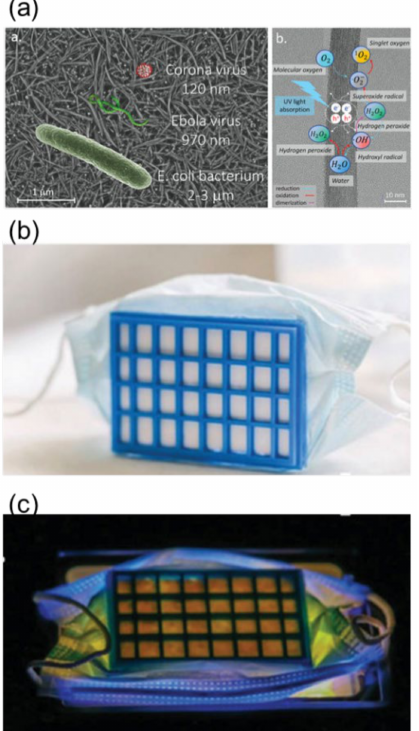
Figure 5. Photocatalytic air filters based on TiO 2 nanowires, ( a ) photocatalytic action for the disinfec- tion of microbial species, ( b ) photograph of photocatalytic mask-based filter, ( c ) mask disinfection under 365 nm. Reproduced with permission from